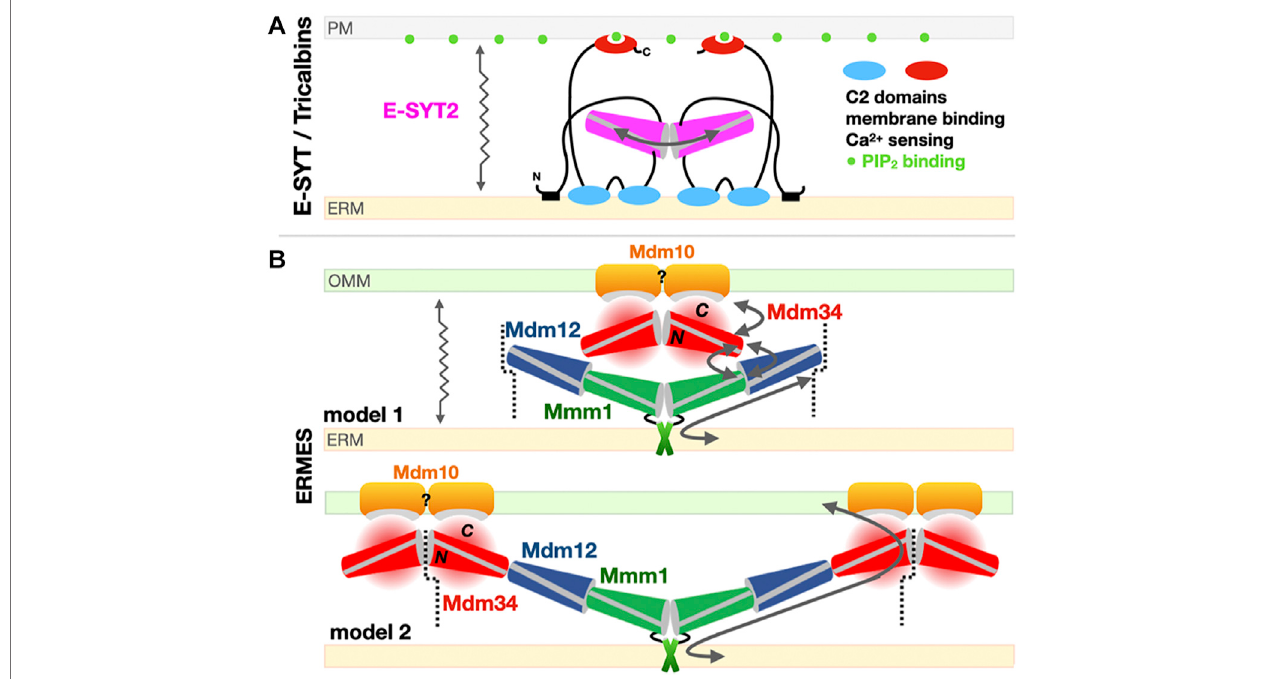
FIGURE 7 | Models for the exchange of phospholipids by SMP domains at contact sites. (A) Tethered shuttle model for SMP-mediated PL exchange by E-SYT2 (yeast Tricalbins) at ER-PM contact sites. E-SYT2 forms dimers via its central SMP domain and is tethered to both membranes (ER and PM) via N-terminal hydrophobic segments and three C-terminal C2 membrane binding domains. The most C-terminal C2 domain binds to PIP 2 (PM) and is regulated by cytosolic Ca 2+ levels. Given its dimensions a sole dimer of E-SYT SMPs cannot directly bridge one membrane to the other; the fl exible linkers are long enough to enable the back-and-forth movement of the dimerized SMPs between the two membranes, alternatively extracting and releasing PLs. (B) Possible “ shuttle with handover ” versus “ lipid conduit ” models of assembly of the three SMP domains in ERMES at ER-Mitochondrion contact sites. Based on the Mdm12/Mmm1 SMP tetramer structure and the reporteddimericassociationstateofMdm34SMP,twomodelscanbeproposed.Mdm10isshownasapossibledimerwhileGem1hasbeenomittedforsimplicity.The dotted line indicates a possible mode of pseudo “ in fi nite ” polymerization of whole independent ERMES units supporting the formation offoci. For Mdm34, N and C refer toits N-terminal SMPdomain andtheuncharacterized andpossibly disorderedC-terminalregion,respectively. Thezigzaggingarrows indicate thattethered-diffusionof SMP domains (in E-SYT2 and possibly in ERMES) is necessary to lipid transfer by enabling back-and-forth movement of their LTP domains between membranes.